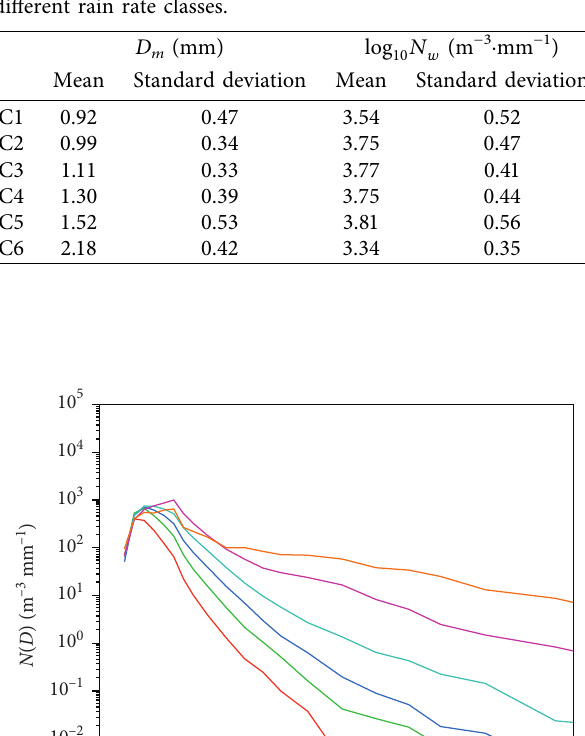
N m and log 10 w in